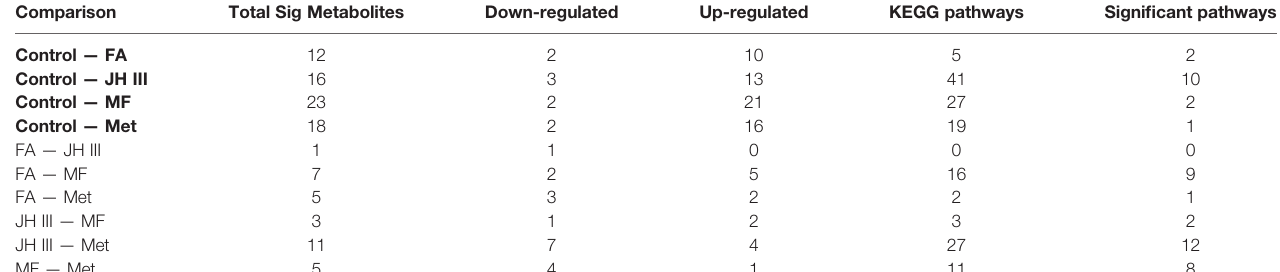
TABLE 2 | Number of signi fi cantly differently expressed metabolites and pathways in response to different hormone treatments to the hepatopancreas of S. paramamosain during ovarian maturation. Comparison Total Sig